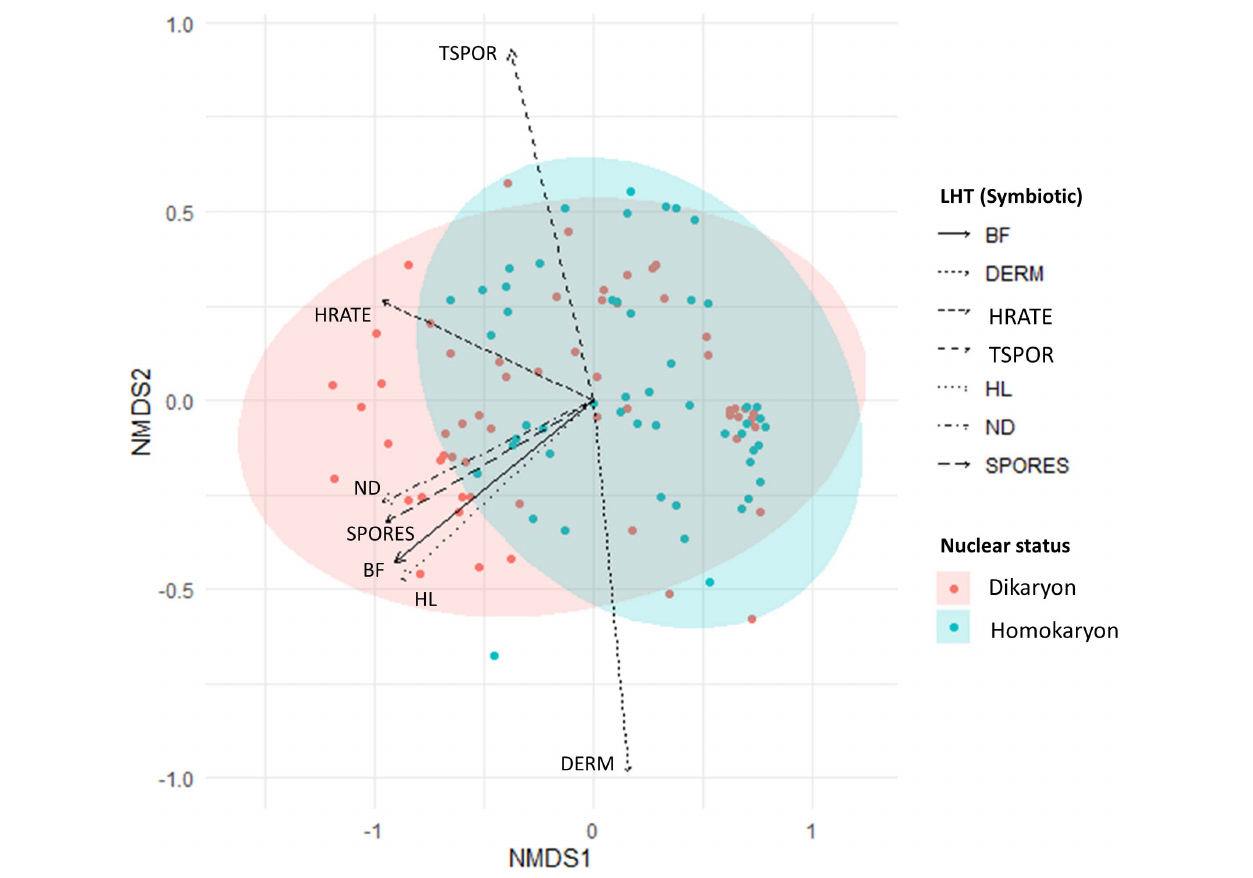
FIGURE 5 | Non-metric multidimensional scaling (NMDS) of homokaryotic (blue dots) and dikaryotic (red dots) strains based on the measured life history traits during the symbiotic growth stage. Stress value = 0.08. The direction of the traits was obtained after fitting the measured traits in the ordination space. BF, branching factor; DERM, days until ERM emergence; HRATE, hyphal exploration rate; TSPOR, time to sporulation; THL, total hyphal length; ND, hyphal network density; SPORES, number of spores. Blue and red ellipse are 95%